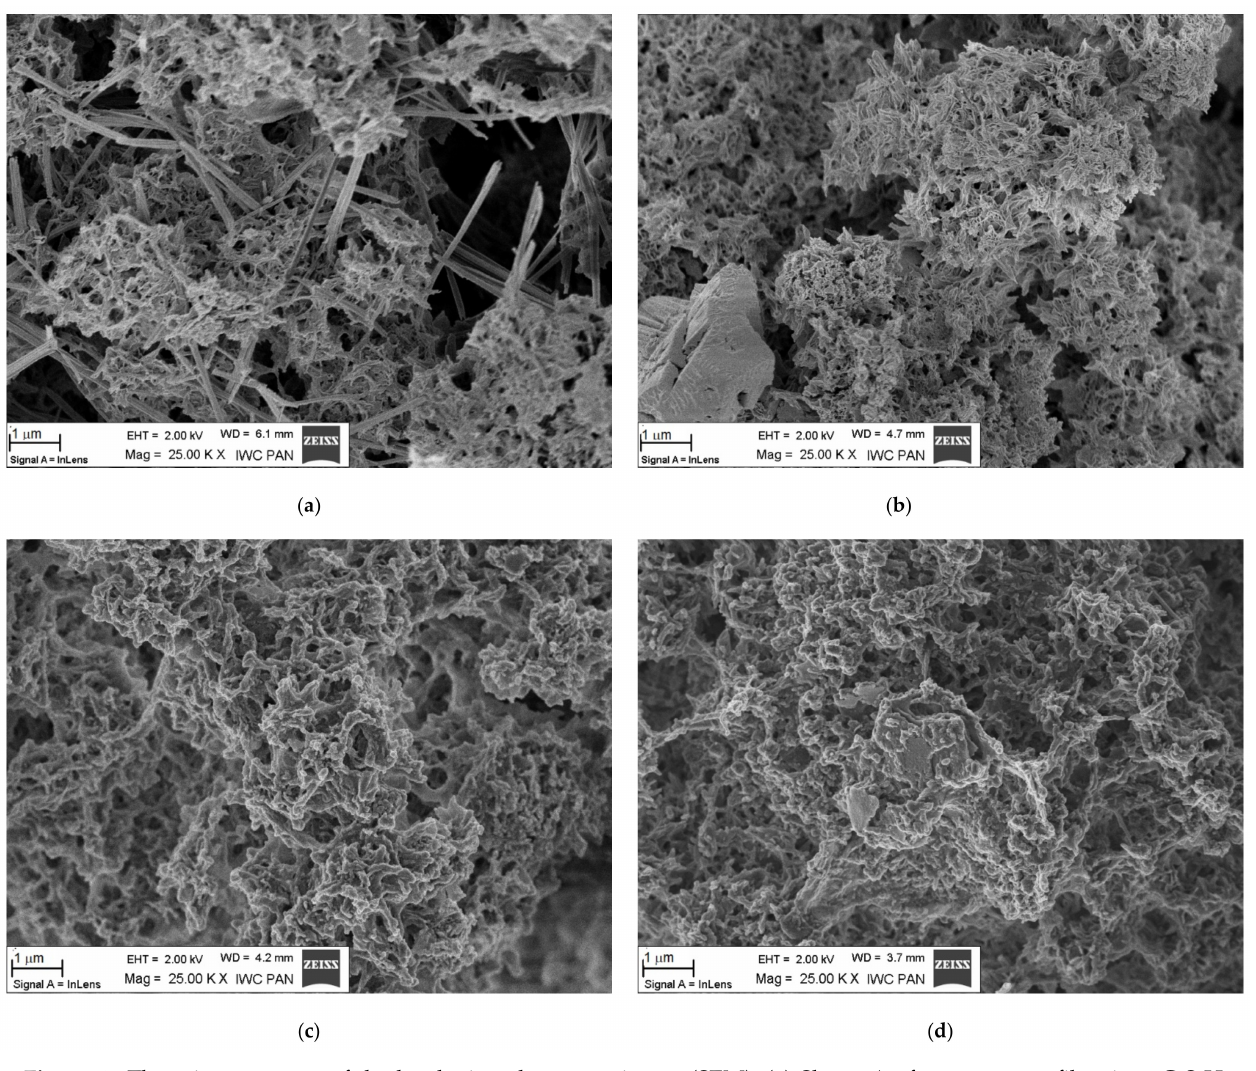
Figure 4. The microstructure of the hardening slurry specimens (SEM). ( a ) Slurry A after tap water filtration: C-S-H, ettringite cluster; ( b ) slurry B after tap water filtration: C-S-H and clinker relicts, pores; ( c ) slurry A after landfill eluate filtration: C-S-H and pores; ( d ) slurry B after landfill eluate filtration: C-S-H, clinker relict, pores. Table 6. Content of selected heavy metals in a hardening slurry and its components. No.